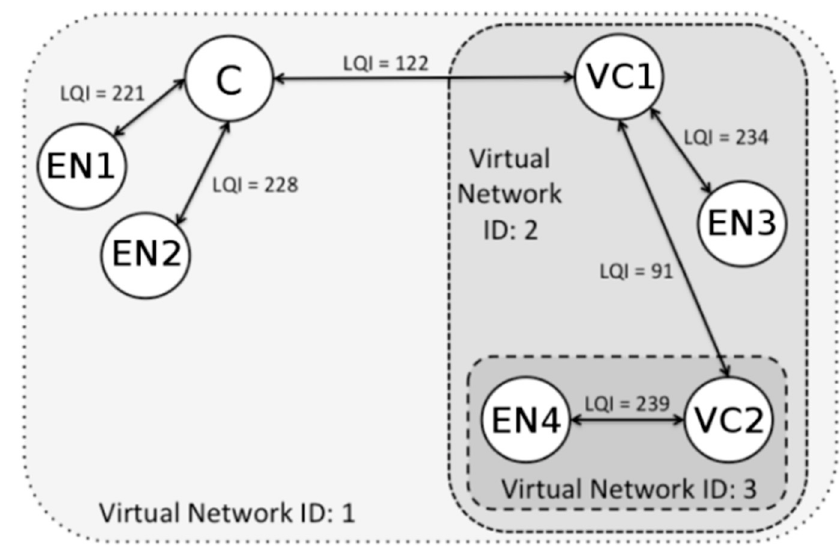
Figure 3. DARP basic network overview.